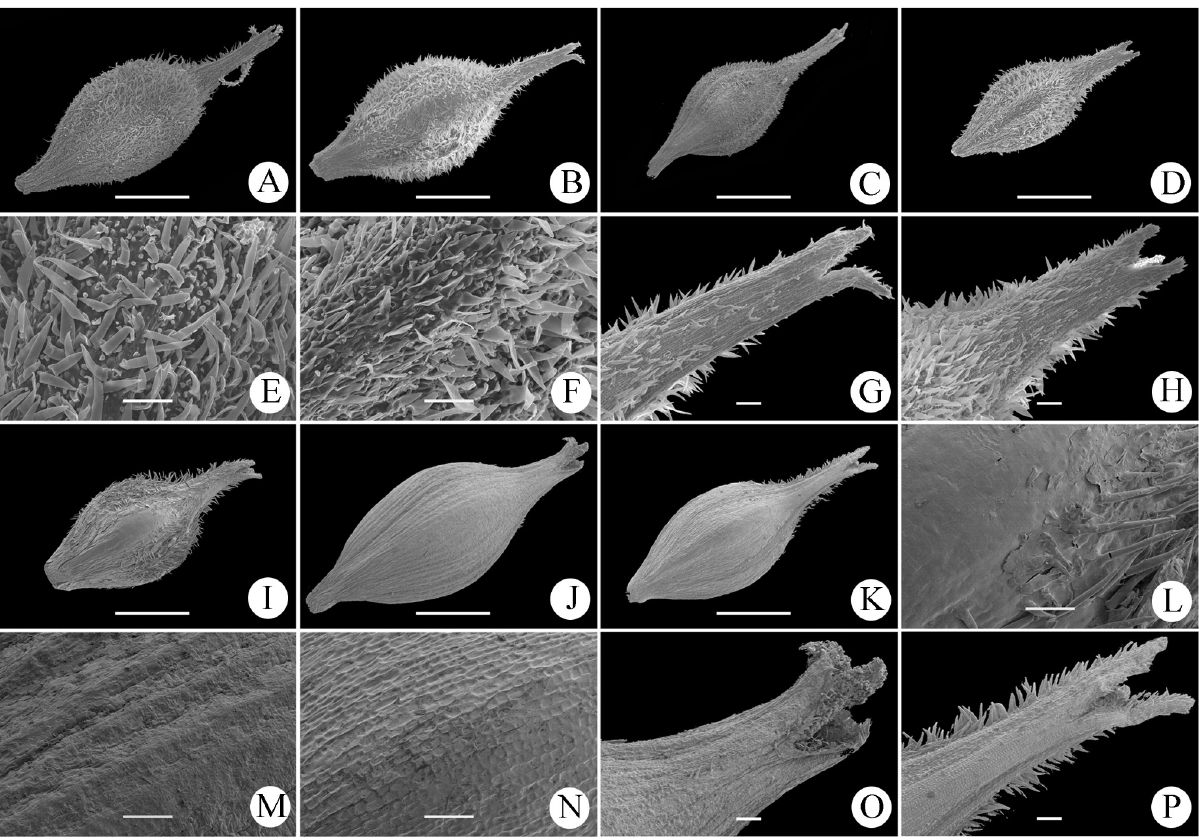
Fig 2. Scanning electron micrographs of the utricle micromorphology of seven species in Carex sect. Occlusae . A, E, Carex borealifujianica ; B, G, C . ligulata ; C. C . hebecarpa ; D, F, H, C . maubertiana ; I, L, C . polycephala ; J, M, O, C . poculisquama ; K, N, P, C . pseudoligulata . A–D, I–K, overview and shape (scale bar = 1 mm); E, F, L–N, surface indumentum (scale bar = 100 μ m); G, H, O, P, beak (scale bar = 100 μ